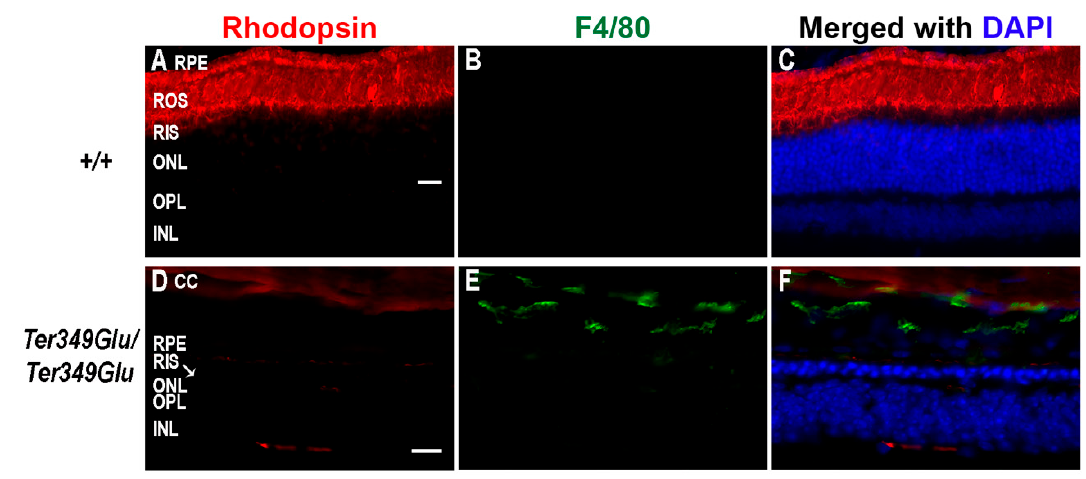
Figure 3. Retinas from retinal dystrophy (RD) mice exhibit monocyte activation. Using fluorescent immunohistochemistry, the presence of activated macrophages was examined in +/+ ( A – C ) and Ter349Glu / Ter349Glu ( D – F ) mice at 12 weeks of age. Retinal sections were labeled with anti-F4 / 80 antigen (green) and K62-82 (rhodopsin, red) antibodies. Nuclei were labeled with DAPI (blue). Autofluorescence in the choroid was observed in the red channel. CC, choriocapillaris; ROS, rod outer segments; RIS, rod inner segments; OPL, outer plexiform layer. Scale bars = 20 μ m.